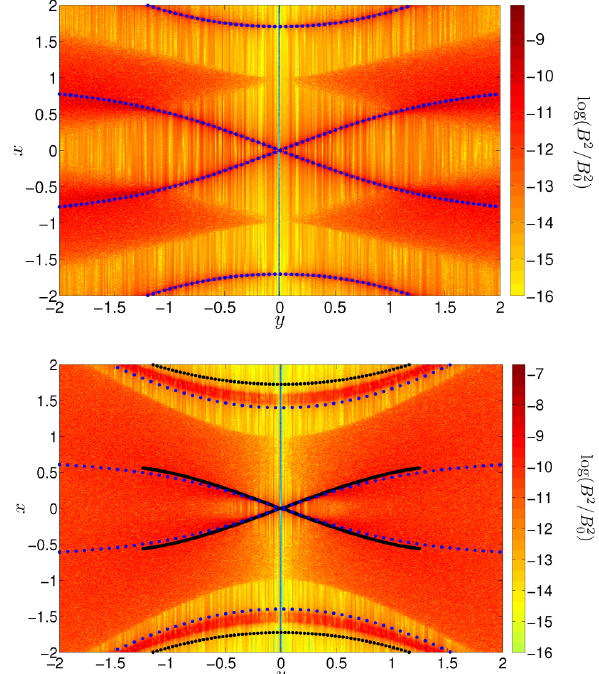
Fig. 19. Same as Fig. 18, but with curves from the analytical models superimposed. Blue dotted line: fluid dispersion relation, Eq. (21); black dotted line: kinetic dispersion relation, Eq. (40). (a) µ = 100, (b) µ =